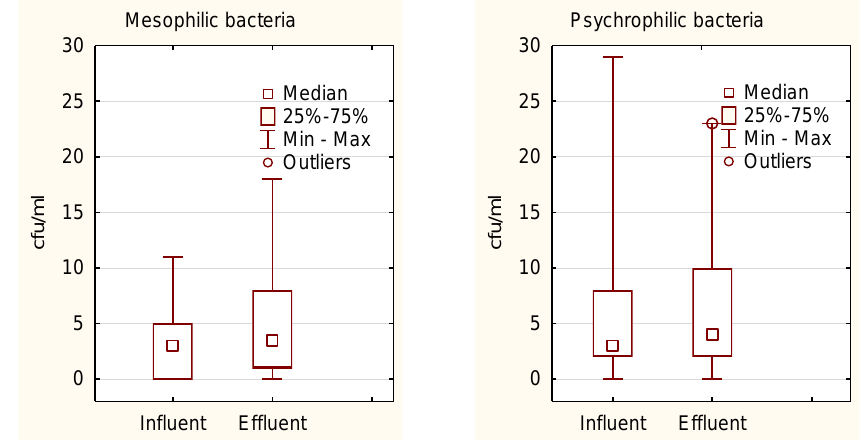
Figure 8. Statistical analysis of microbiological results obtained for water before and after biofiltration process on granular activated carbons.